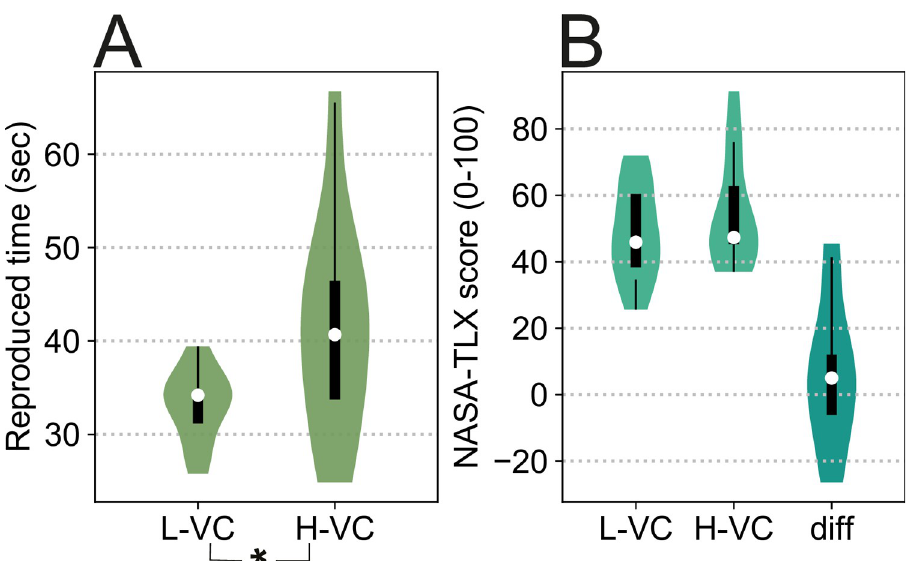
Fig 6. Task B : Experiment results. A : Experiment 3 . Participants take longer to realize 30s have passed in H-VC, which suggests that time is compressed in the presence of larger perceived visual changes. B : NASA-TLX score (workload measure) for the visual complexity production tasks of each level. Right violin plot (“diff”) shows individual differences in NASA-TLX score (L-VC MINUS H-VC). Note that the negative values in the diff violin plot mean that for some users L-VC was experienced as more demanding than H-VC. Significant differences are marked with an asterisk.